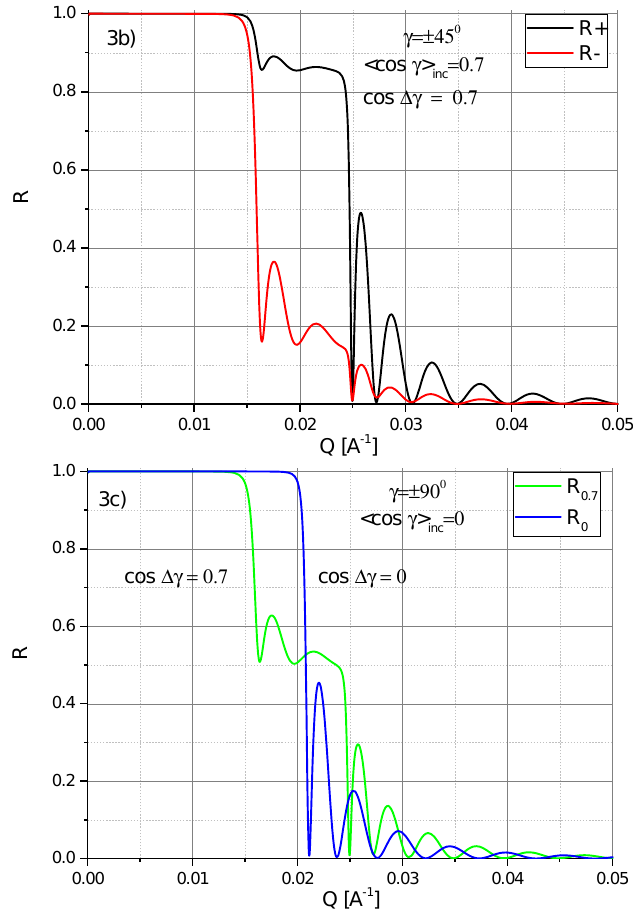
Figure 3. Calculated specular reflectivities R + and R − for a 100 nm thick iron film with reduced magnetization. ( a ) R + (black solid line) and R − (red solid line) for a mean magnetization M = 0.5 M sat parallel to the Y-axis ( γ = 0 ◦ ); ( b ) similar to ( a ) but with the mean magnetization tilted by the angle γ = ( ± ) 45 ◦ ; ( c ) green line: similar to ( a ) but with the mean magnetization tilted by the angle γ = ( ± ) 90 ◦ ; blue line: reflectivity for a mean magnetization M =